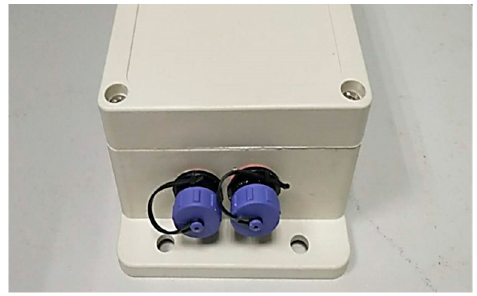
Figure 3. Plug perforated on the side of the device box.